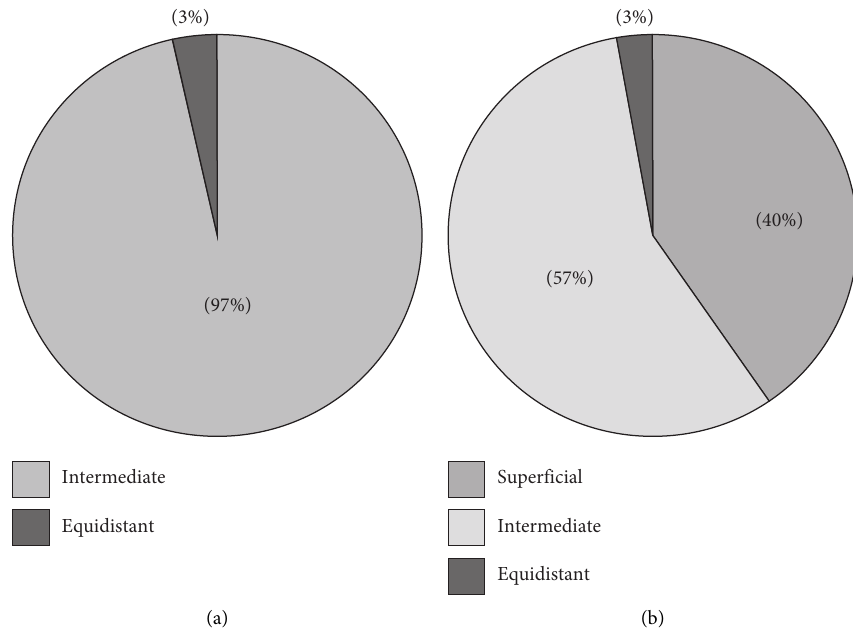
Figure 4: Morphological characteristics of the fruit of 146 FFNC ecotypes. (a) Ridge pair appearance. (b) Primary furrow depth.